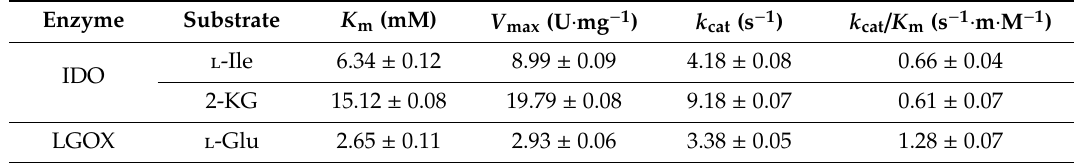
Table 1. Kinetic parameters of IDO and LGOX.